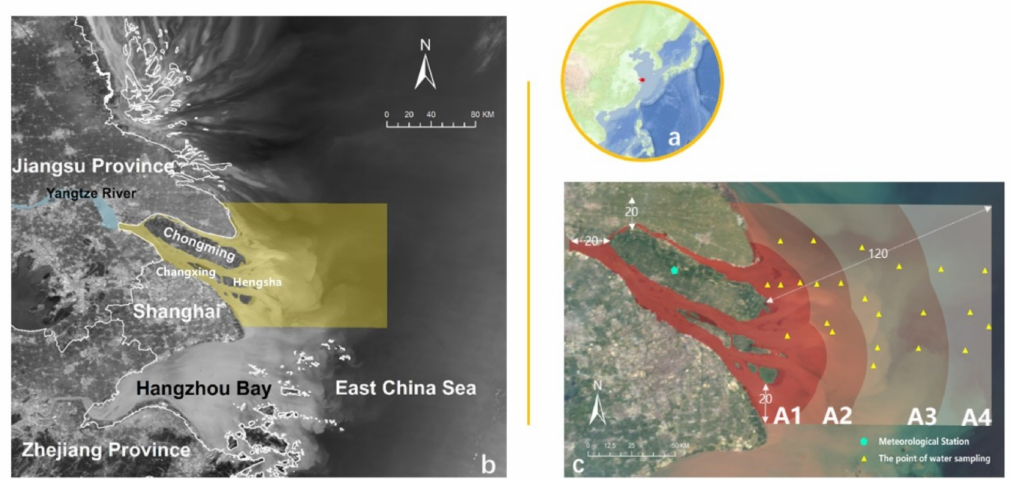
Figure 1. ( a ) The study area is distributed in eastern China and is backed by Eurasia and faces the Pacific Ocean. ( b ) Yangtze River runoff is divided into a northern tributary based on Chongming